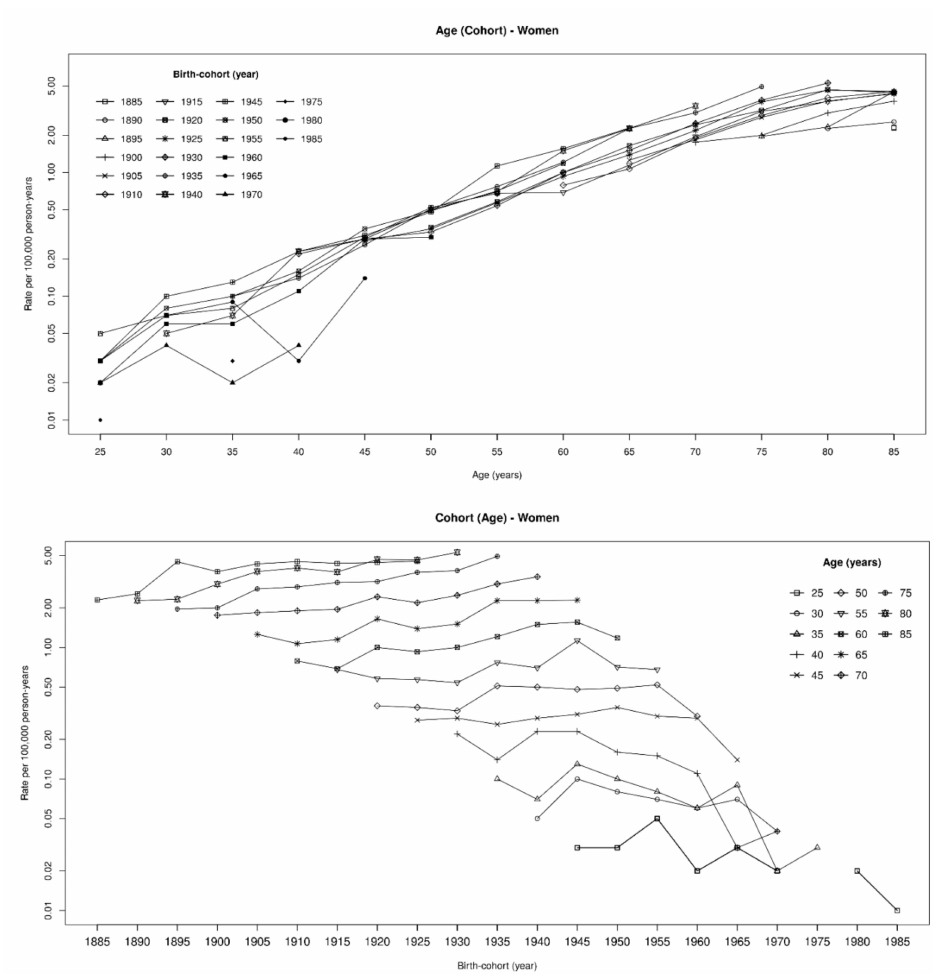
Figure 2. Malignant pleural mesothelioma death rates ( × 100,000) by age and birth cohort. Women, Italy,